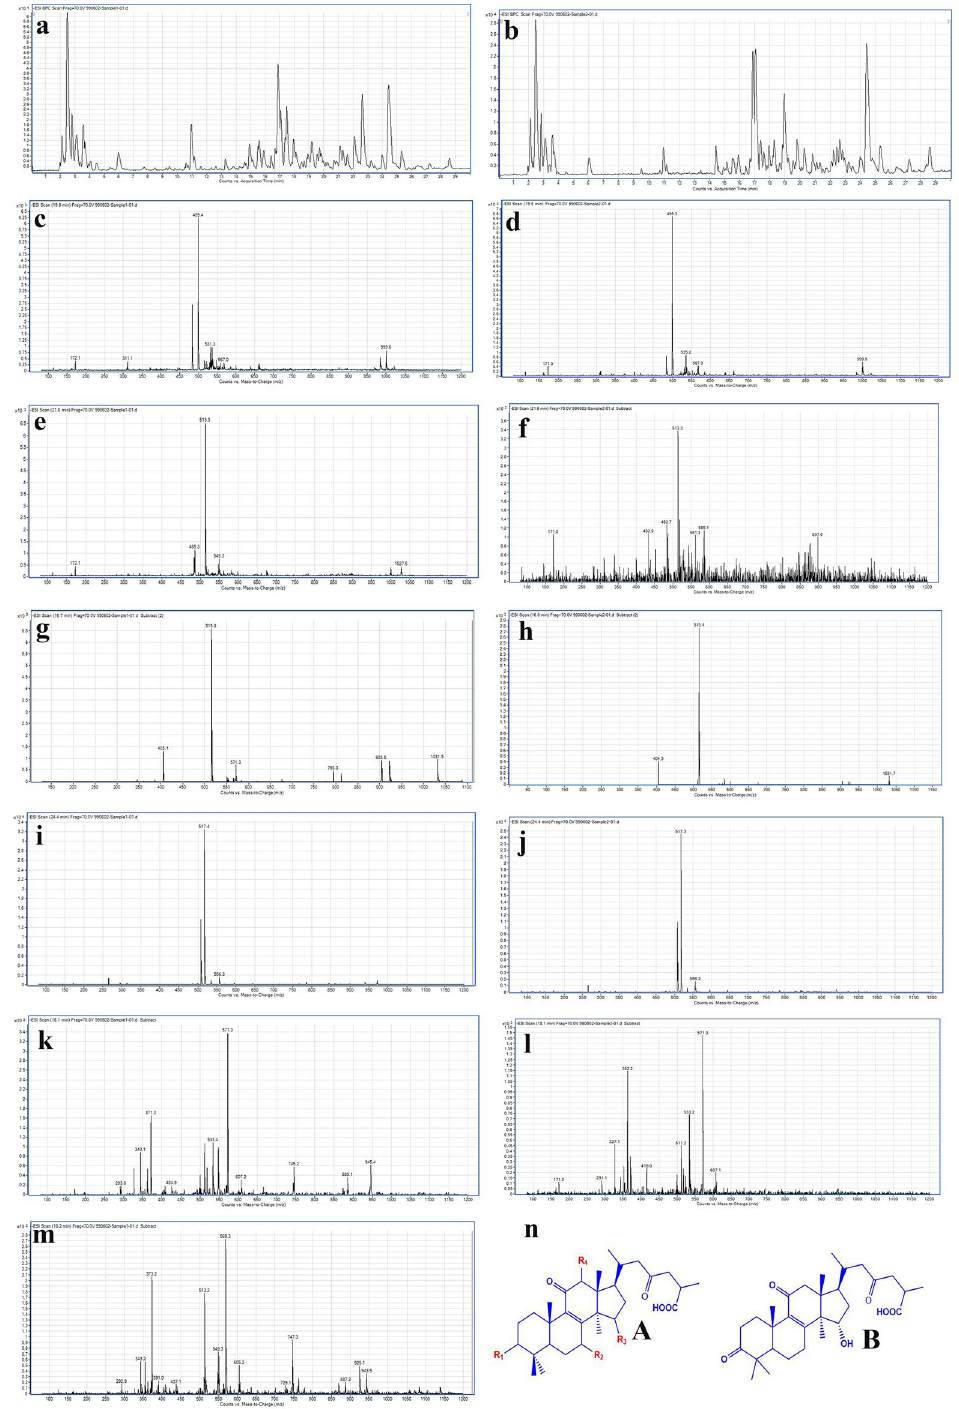
Figure 5. ( a,b ) The extracted ion chromatogram(EIC) of herbal extract and nanoparticles, respectively. ( c,d ) Ganolucidic acid mass spectrum, related to the herbal extract and nanoparticles, respectively. ( e,f ) Ganoderic acid D mass spectrum, related to the herbal extract and nanoparticles, respectively. ( g,h ) Ganoderic acid B mass spectrum, related to the herbal extract and nanoparticles, respectively. ( i,j ) Ganoderic acid C 2 mass spectrum, related to the herbal extract and nanoparticles, respectively. ( k,l ) Ganoderic acid H mass spectrum, related to the herbal extract and nanoparticles, respectively. ( m ) 12-acetoxy ganoderic acid F mass spectrum, related to the herbal extract. ( n ) The structure of the identified